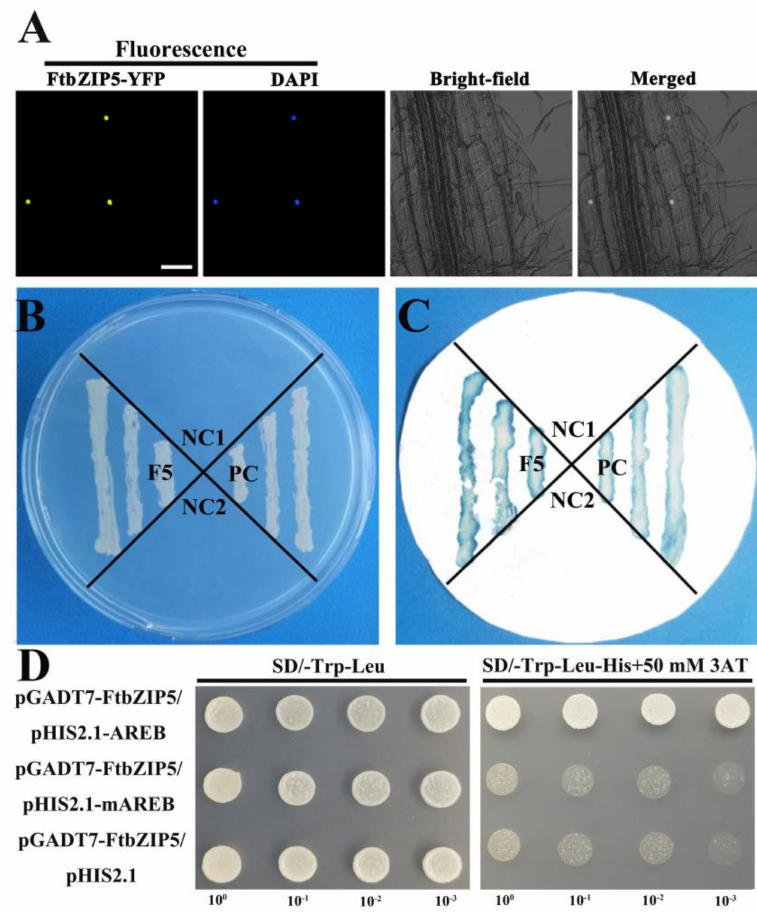
Figure 3. Photographs of FtbZIP5 localization, transcriptional activity and binding to ABRE cis -acting elements. Photographs of FtbZIP5 localization and transcriptional activity experiments. ( A ) Subcellular localization of FtbZIP5 protein. Scale bars = 100 µ m ( B ) Culture of the transformed yeast cells on SD / -His-Trp medium. ( C ) Experimental analysis of galactosidase staining with x- β -gal on filter paper. NC1:AH109 cells and NC2:pBridge empty plasmids were used as a negative control. PC:pBridge- FtbHLH2 was the positive control used to evaluate the transcriptional activity of pBridge- FtbZIP5 . ( D ) Yeast one hybrid experiment with 3 × ABRE or 3 × mABRE3 as bait. The yeast cells carrying pGADT7- FtbZIP5 + pHIS2.1-3 × ABRE / pHIS2.1-3 × mABRE / pHIS2.1 grew on SD / -Trp -Leu and on SD / -Trp-Leu-His containing 50 mM of